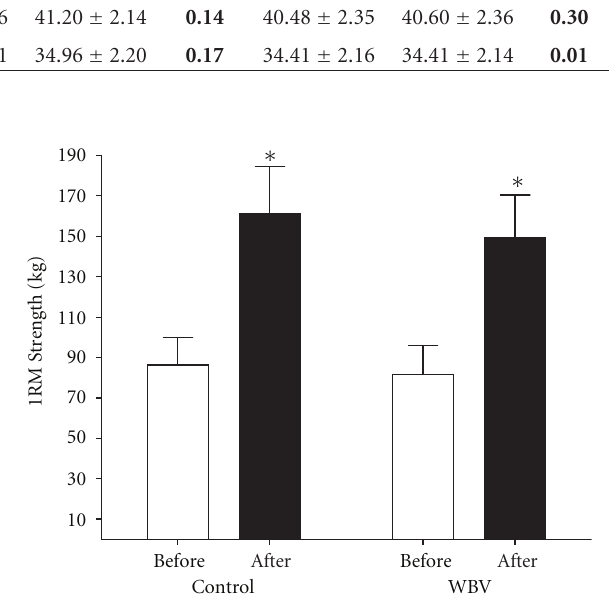
Figure 1: Mean ( ± SE) absolute change in dynamic single repetition maximum (1RM) squat strength (kg) before and after the 4wk intervention. The training protocol resulted in 1RM increases in both groups ( P < 0 . 05), as denoted by an asterisk. However, the magnitude of change between training groups was not significantly di ff erent ( P = 0 .